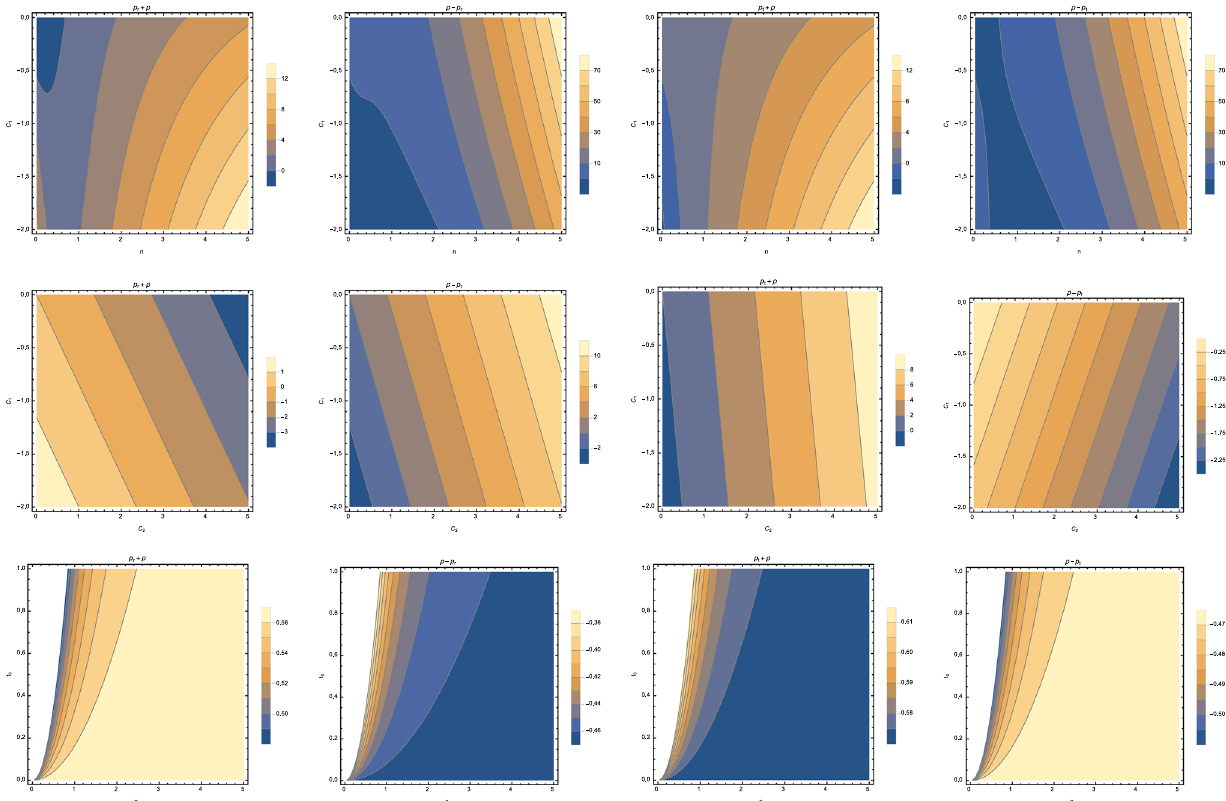
Fig. 3 The above panels shows the variations in ρ ± p r and ρ ± p t w.r.t changing parameters corresponding to Eq. (22). Here C 1 , C 2 is taken with agreement to the constraints set by f ( R ) viability conditions